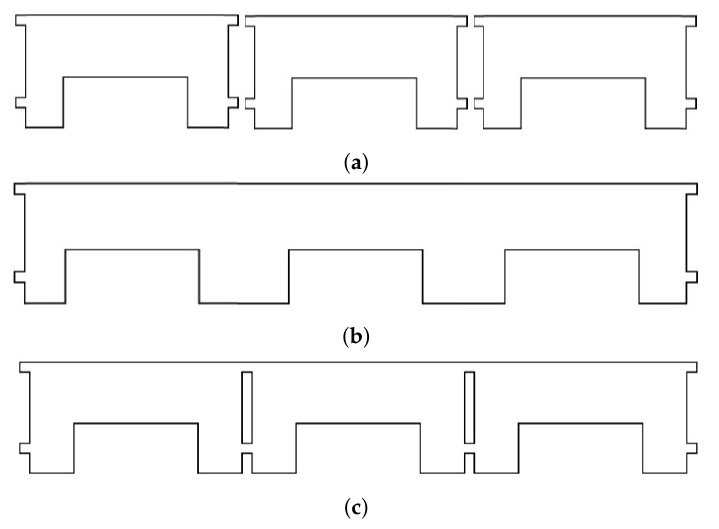
Figure 6. Three-phase lamination core layouts: ( a ) type I, ( b ) type II and ( c ) type